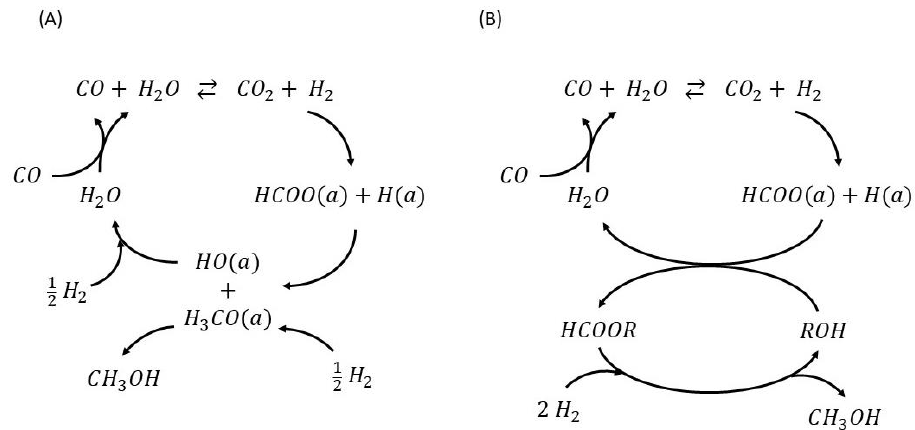
Figure 2. Illustration of two commonly accepted pathways for methanol synthesis. ( A ) The typical gas phase mechanism proceeds via a formate intermediate, which is hydrogenated into a methoxy group before methanol is released. ( B ) In the liquid phase mechanism, the formate reacts with an alcohol to form an ester before methanol is released [37].